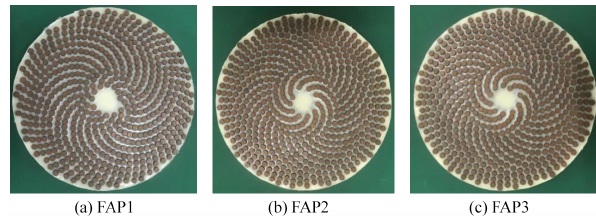
Figure 10. A total of three types of fabricated